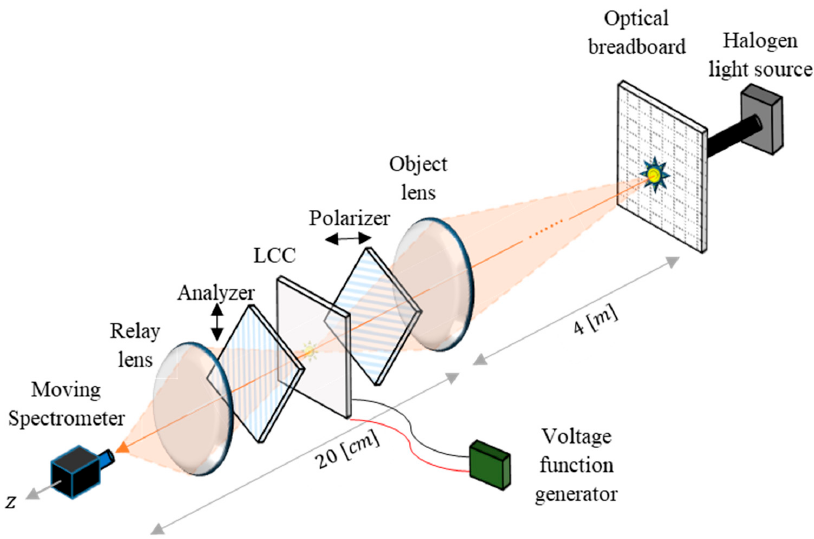
Figure 2. The optical calibration setup scheme. A point source is generated by directing halogen light with an optical fiber to specific locations on the optical breadboard placed perpendicular to the optical axis. An objective lens forms an image of the light source on the LCC, which is located between a crossed polarizer and analyzer. A relay lens maps the image 1:1 to the spectrometer plane. The voltage applied to the LCC is adjustable using the voltage function generator.